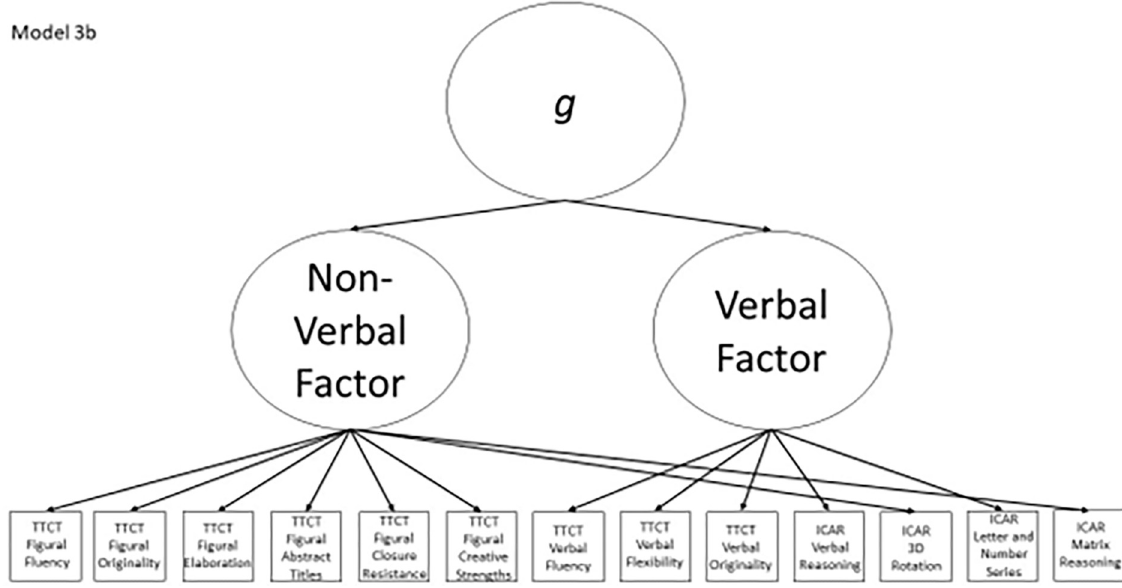
Fig 9. Confirmatory factor analysis diagram for model